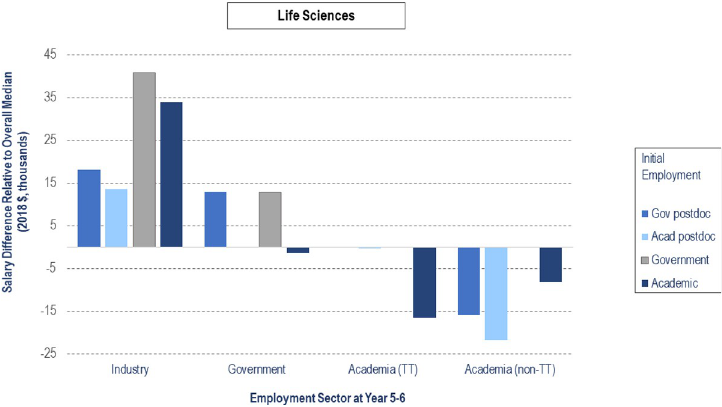
Fig 4. Median salary comparison at Year 5–6 for life sciences by initial employment type and